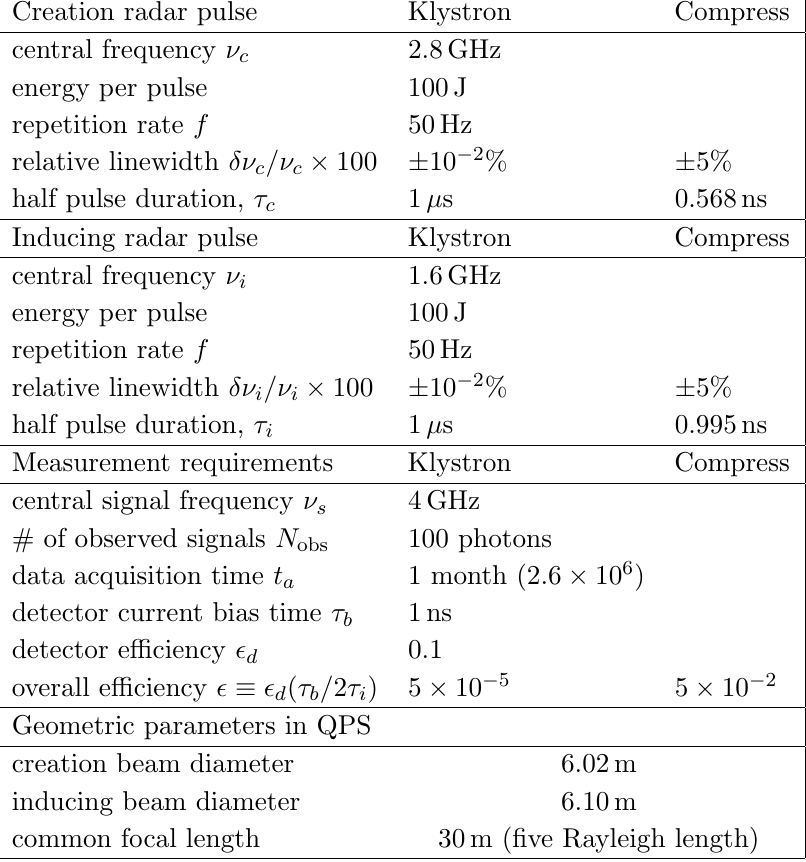
Table 1 . GHz-band pulsed beam parameters similar to the existing klystron [10] and the com- pressed case reaching the Fourier transform limit (cid:28) j (cid:2) 2 (cid:25)(cid:14)(cid:23) j (cid:21) 1 = 2 for j = c or i . g=M for the given values of m and N . Dominant background photons are expected obs from blackbody radiations in the same spectrum width as that of the signal photons, (1 (cid:6) (cid:24) 0 : 05) (cid:23) . The unavoidable blackbody source is the entrance horn connected to the s qubit senor. The total number of background photons is evaluated as N = 0 : 5 photons bkg by assuming that the horn and sensor temperatures are kept at T = 10 mK with the inner surface area of the cone-type horn (cid:1) S = (cid:25)(cid:21) 2 for signal photon wavelength (cid:21) = c=(cid:23) s s s